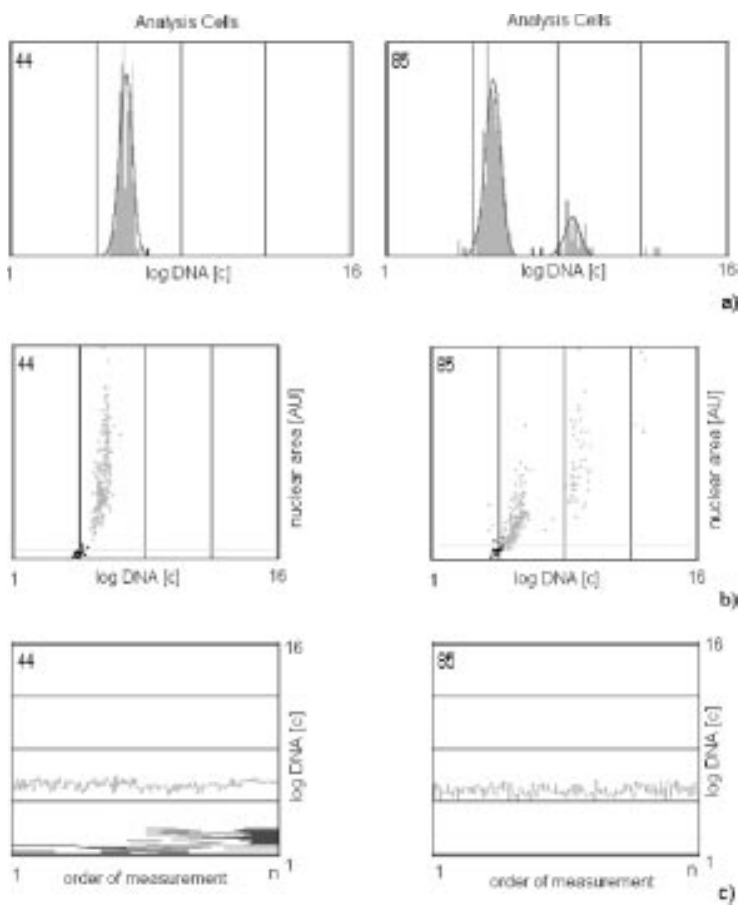
Fig. 5. Part of the EUROQUANT result display, dealing with internal quality control issues. (a) DNA histograms of two samples from breast cancer imprints. Case 44: stemline at 2.55 c with cv of 5.34%; case 85: stemline at 2.38 c with cv of 6.22%; (b) Scattergrams of nuclear area vs. DNA content in those two samples. The deviation of the ellipsoid from the vertical axis, expressed as correlation coefficient r , indicates glare and/or diffraction effects beyond the ESACP guidelines in both specimens ( r = 0 : 56 in 44; r = 0 : 67 in 85). Those effects lead also to a shift in the modal peak value of analysis cells to the right (compared with the smaller reference cells, printed as black dots); (c) Sequential displays of the DNA content of cells within a histogram peak (same measurements as in (a), showing a statistically significant departure from homogeneity in sample 44 ( p = 0 : 000 in 44; p = 0 : 26 in